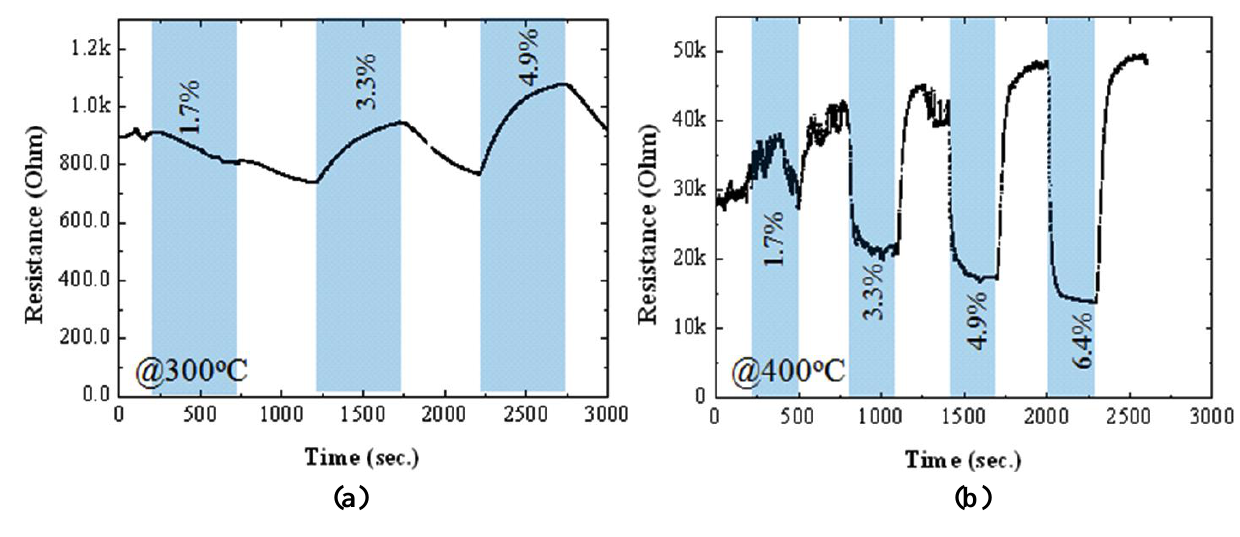
Figure 6. Change in resistances with respect to time of the un-doped SnO alternating environment of N (a) 300 °C and (b) 400